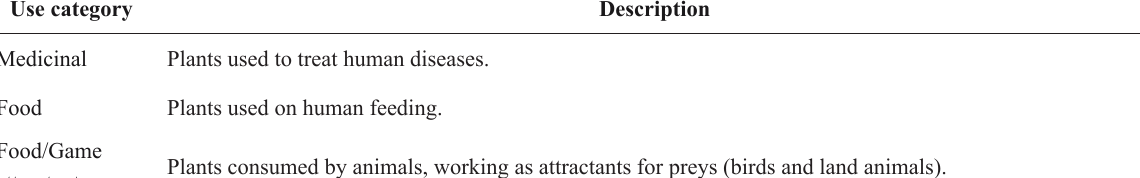
Use categories adopted for the classification of species inventoried in archaeological sites in